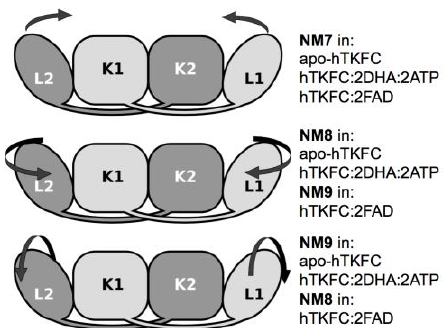
Figure 3. Schematic interpretation of the major movements contained in non-trivial normal modes shown in Figure 2. These movements can be compared to the three universal modes [22] defined for bilobate structures: (upper) hinge-bending, (middle) twisting, (lower) wobbling. Additional descriptions of the NM7 – NM9 modes can be found in the text. In some cases, the normal modes of L1 and L2 differ slightly (see the text).